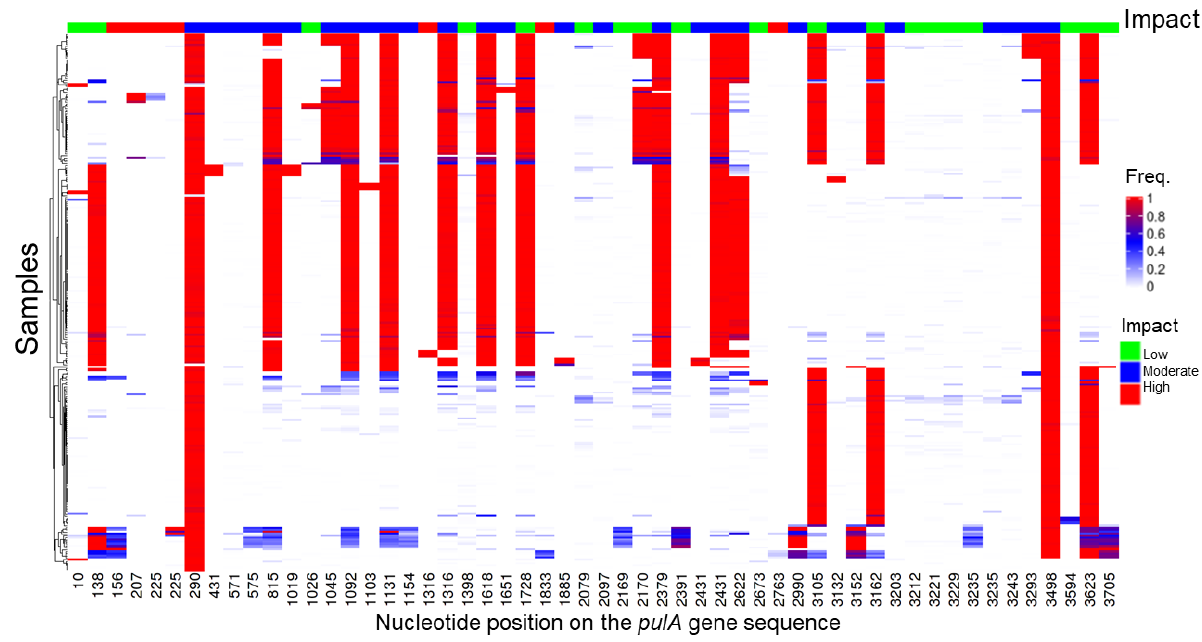
Figure 4. Small variants in the L. crispatus amylopullulanase gene in the metagenome of vaginal microbial communities. The list and frequency of SNPs and short indels (small variants) identified in the 270 vaginal microbiome samples that showed at least ten times full length coverage for the pulA gene sequence. The variants were classified in terms of their impact on the protein sequence.